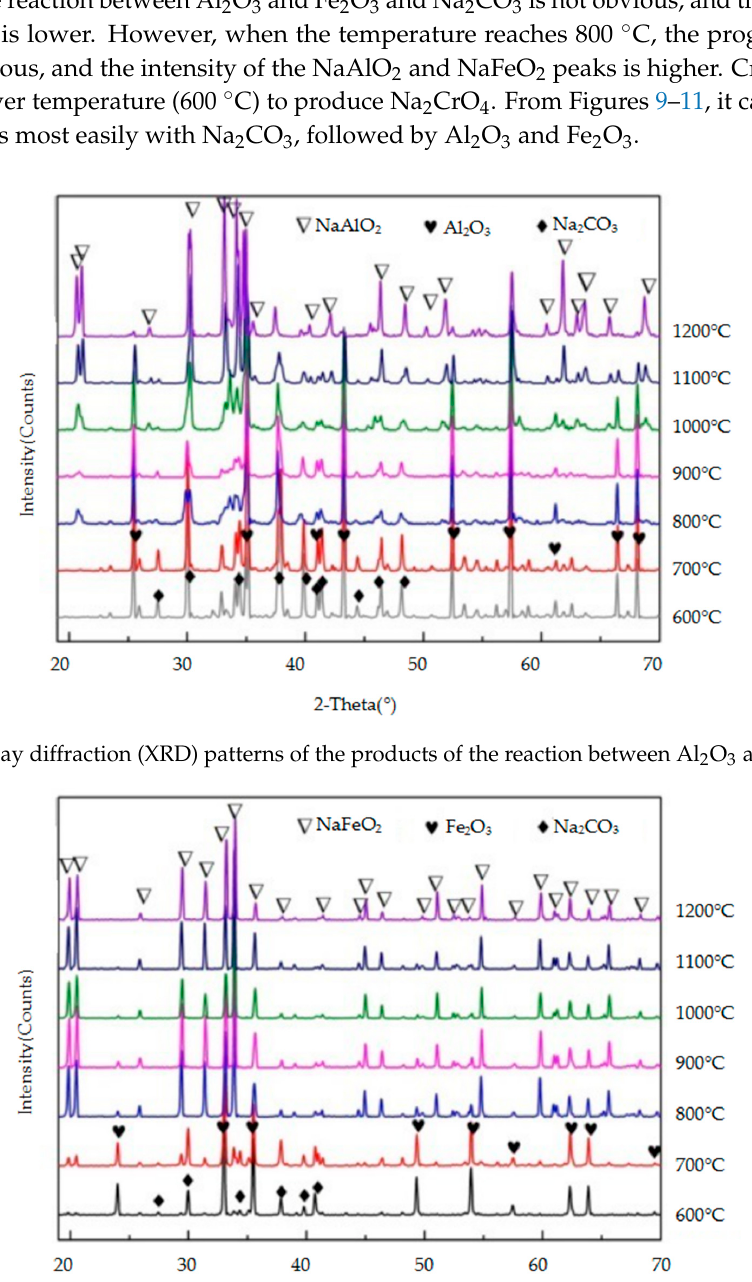
Figure 10. XRD patterns of the products of the reaction between Fe 2 O 3 and Na 2 CO 3 .